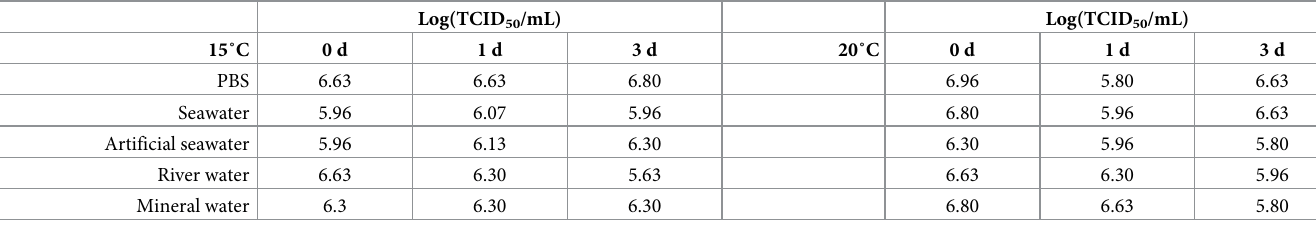
Table 2. The 3-day stability of PRCV in natural and artificial salt- and freshwater media.